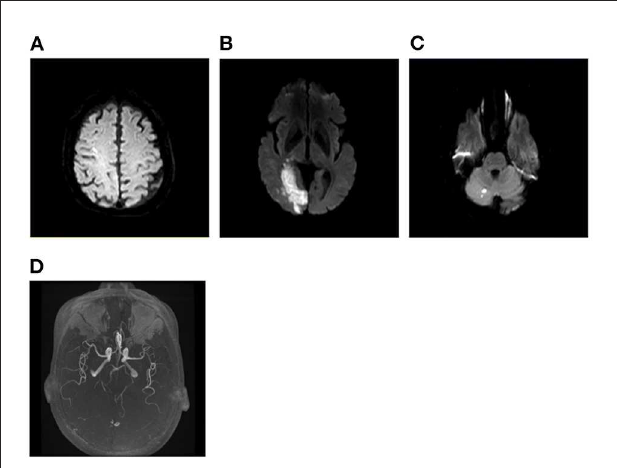
FIGURE5 A case of peri-operative infarction. A 72-year-old man presented with left homonymous hemianopia, weakness of left upper and lower limbs, and numbness of left face and limbs after undergoing lung surgery. Infarcts were distributed at right cortex of frontal lobe, right occipital lobe, and right cerebellar hemisphere (A–C) . Vascular evaluation showing severe stenosis of right PCA (D) . PCA, posterior cerebral artery.